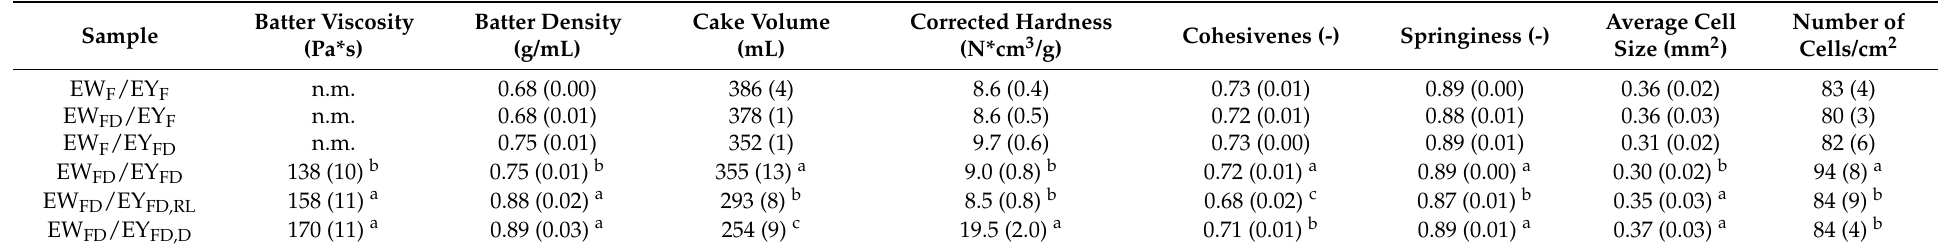
Table 2. Properties of sponge cake batters and sponge cakes prepared with different egg white and/or egg yolk treatments prior to batter preparation. Sample codes are shown in Table 1. Standard deviations are indicated between